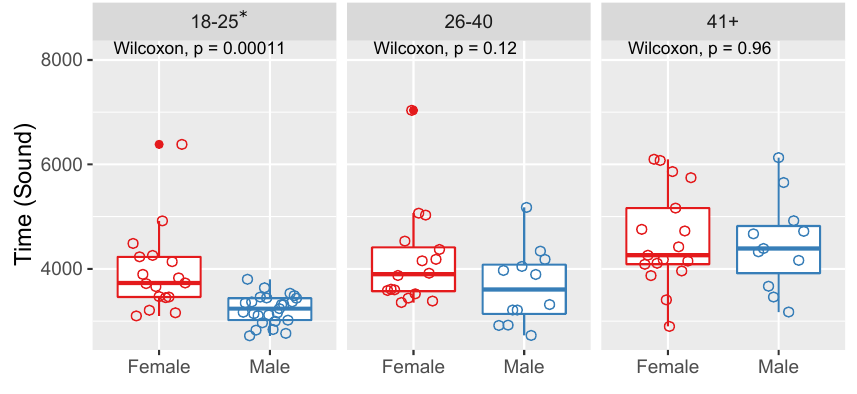
Figure 10. Boxplots comparing age groups of males and females regarding times of activation in “sound” condition. Significant differences are marked with